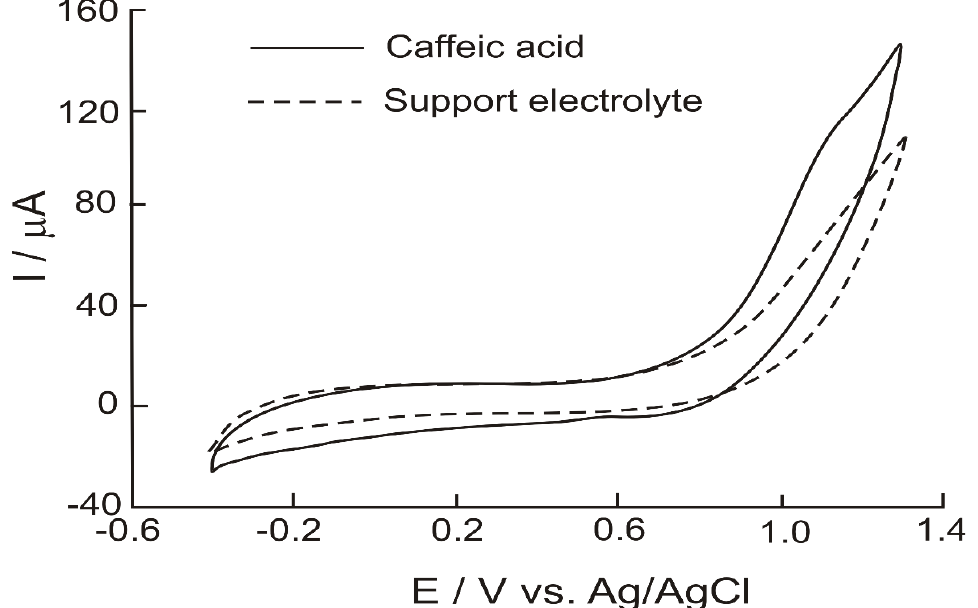
Figure 2. Cyclic voltammogram of SPCE/HRP biosensor immersed in electrolyte support solution (10 − 2 M PBS pH 7–10 − 2 M hydrogen peroxide), (dashed line); cyclic voltammogram of SPCE/HRP biosensor immersed in 30 µ M caffeic acid solution in electrolyte support solution (solid line).